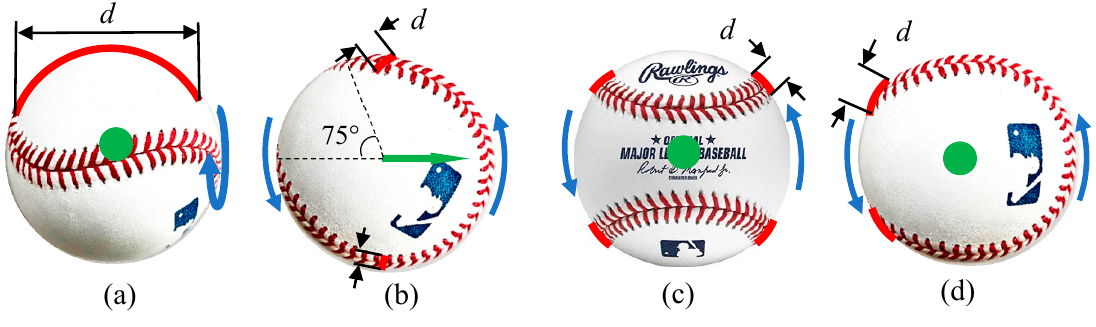
Figure 7. Seams exposed to the max flow for each spin orientation. The green dot or arrow indicates the speed direction, the blue arrow indicates rotation direction and the red line highlights the seams that are exposed to the max flow at that ball orientation. ( a ) Four-seam back spin. ( b ) Two-seam back